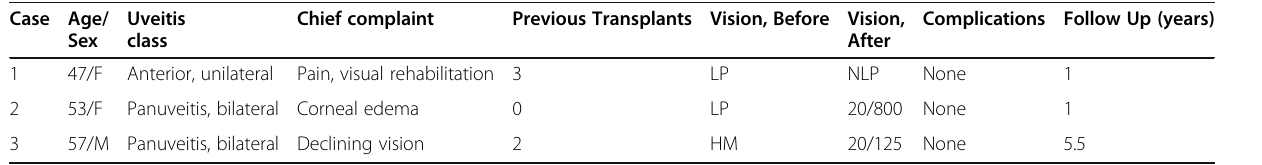
Table 1 Clinical profile of